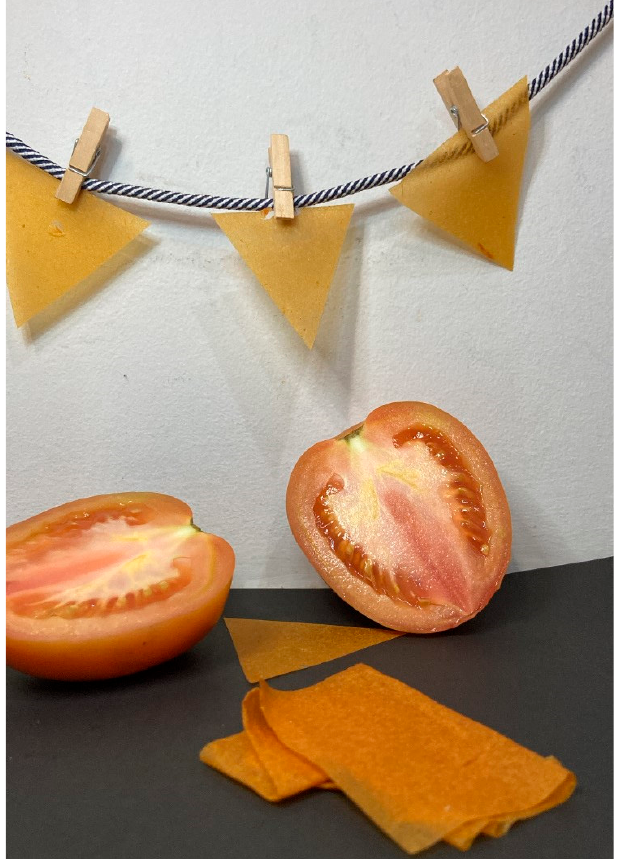
Figure 5. Visual appearance of the film produced by continuous casting. Table 2. Results from sensory evaluation of nachos covered with guacamole (NG) or with film (film #3, produced by continuous casting) and guacamole (NFG).